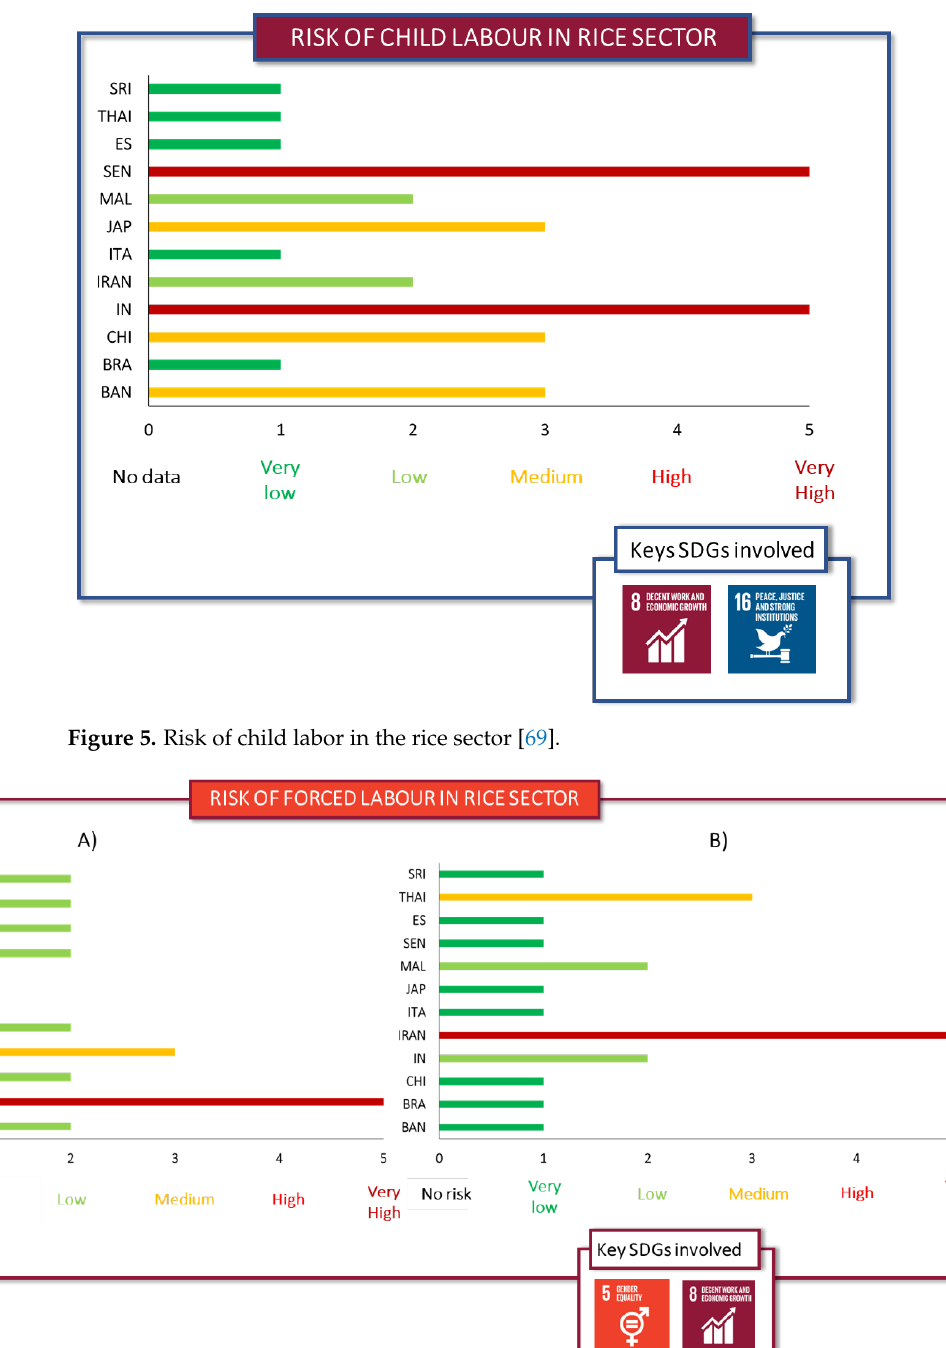
Figure 6. Risk of forced labor in rice production in that country [70,71]. ( A ) expressed according to goods produced by forced labor (Number of goods in the sector). ( B ) expressed according to frequency of forced labor (Cases per 1000 inhabitants in the country)